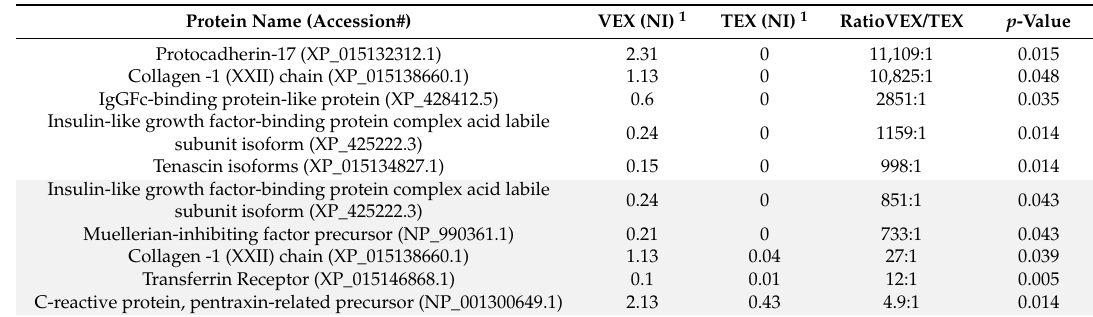
Table 5. Serum VEX-overrepresented proteins.